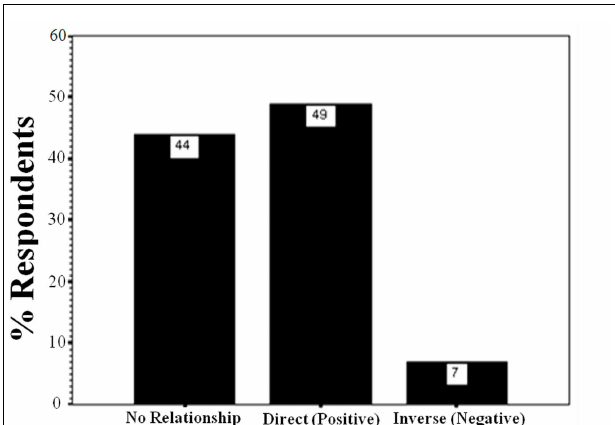
FIGURE 4 | Percentages of participants predicting what type of relationship they tacitly think there should be between vividness ratings and speed of imagery in Experiment